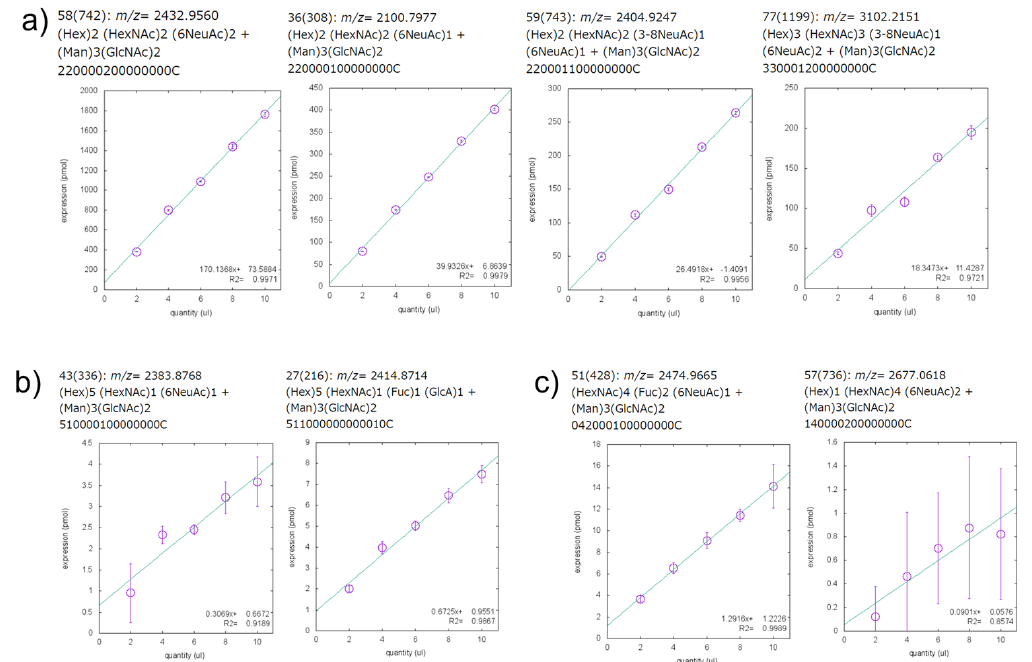
Figure 5. Screenshot of part of each_glycan_quant_point_rcut.html file. ( a ) Calibration curves of the four most abundantly expressed glycans, ( b ) Calibration curves of two mannose-rich hybrid glycans, and ( c ) two glycans with the LacDiNAc structure. Each panel includes m / z , glycan composition, 15-digit glycan composition ID, and calibration curve graph. The 15-digit glycan composition ID indicates the number of each residue in the order shown in Table S1. The ‘C’ at the right end indicates the M3 core structure ((Man)3 (GlcNAc)2). In the graph of the calibration curve, the linear function of the completion line and the fitting R 2 are shown in the lower right corner. Table 4. Estimating glycans with R 2 > 0.8 in calibration curves and hyperlink to Glyconnect